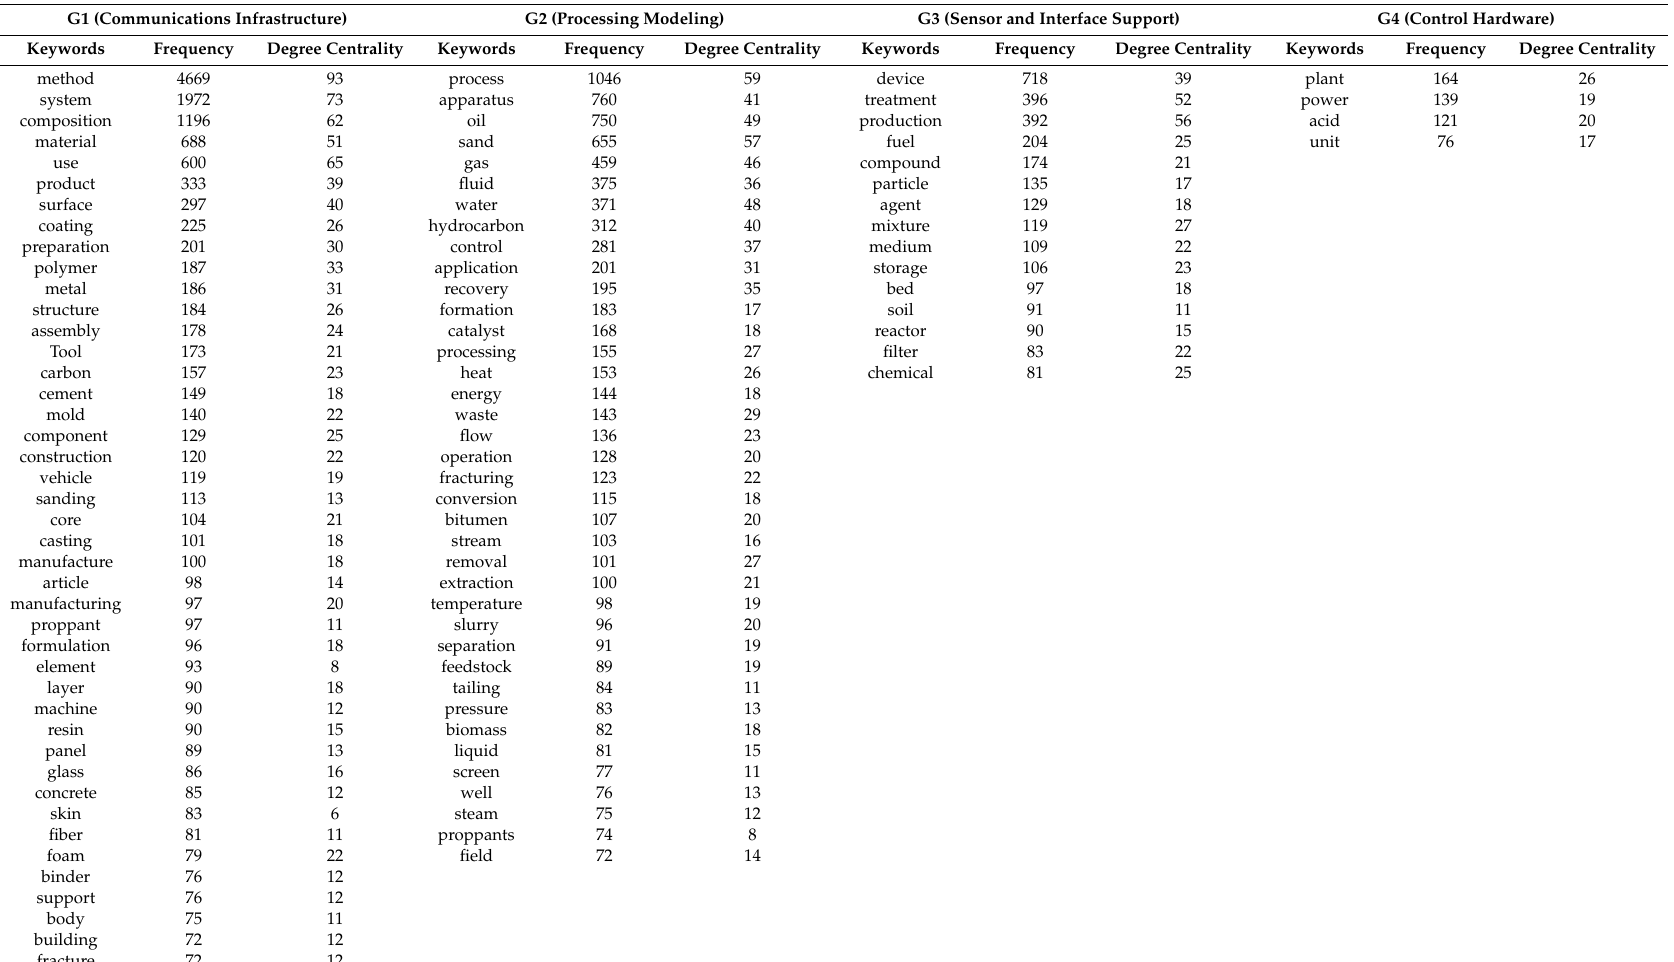
Table 1. Results on group network analysis of digital oil